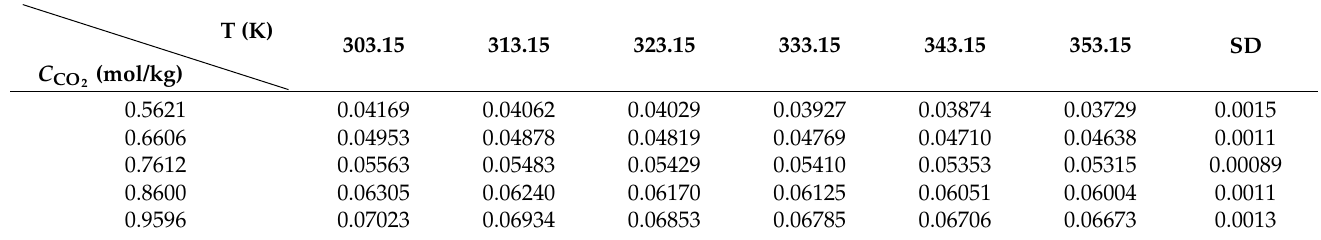
Table 4. The Raman peak intensity ratio of CO 2 + n -decane mixture at different temperatures and CO 2 concentrations.